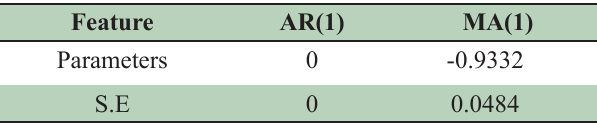
Table-IV: Detail of estimated parameters along with standard error (S.E) of ARIMA (0, 2,